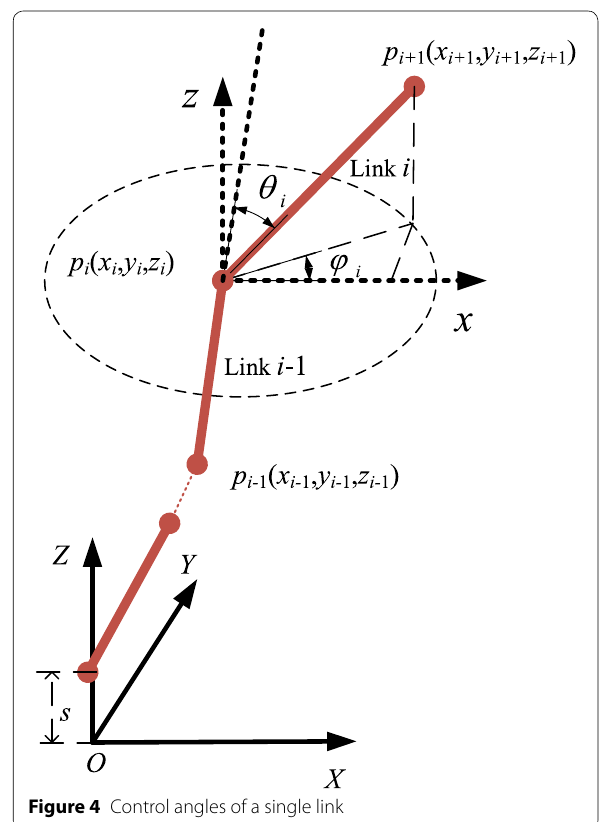
Figure 4 Control angles of a single